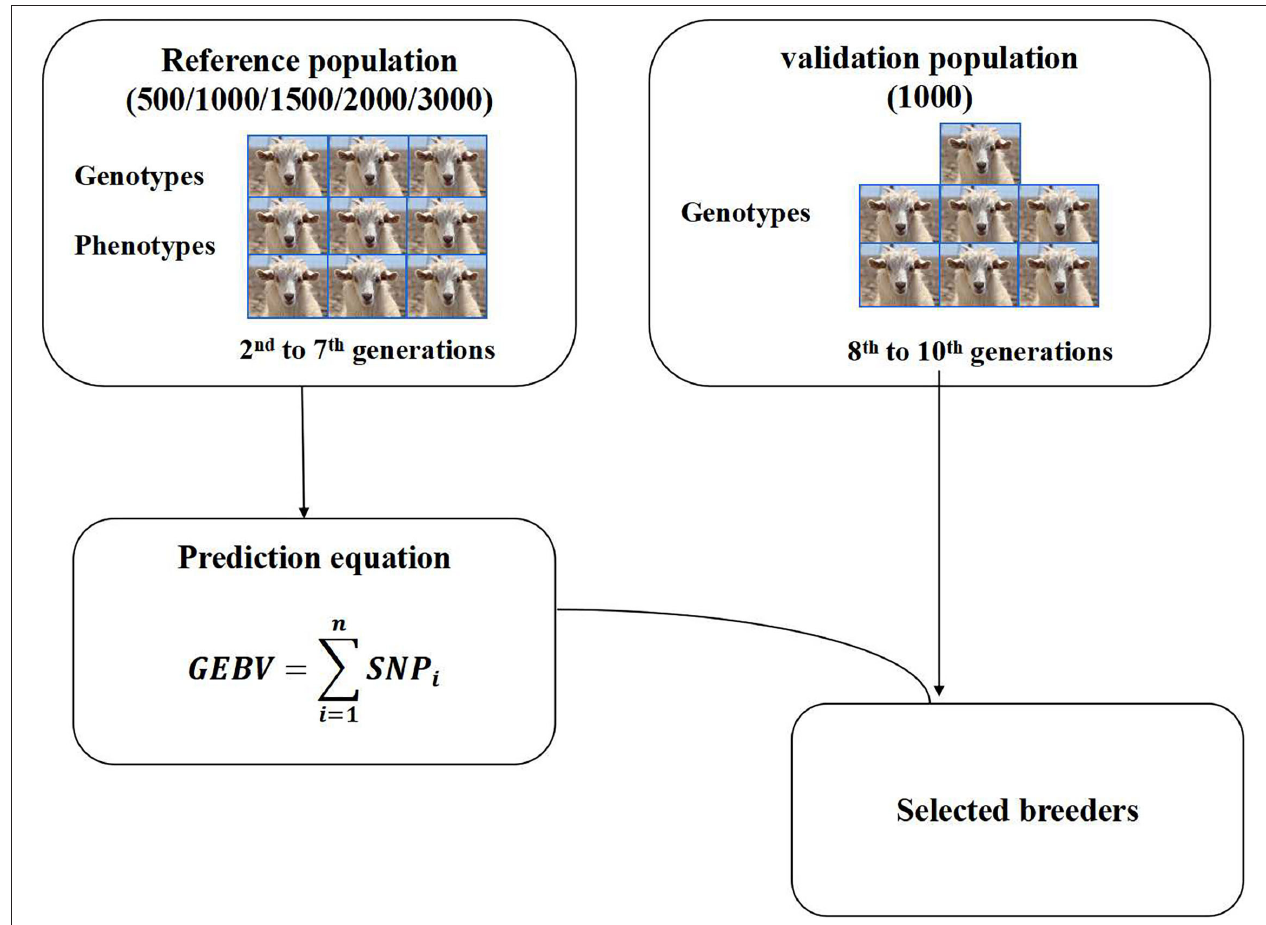
FIGURE 1 | Genomic selection scheme.